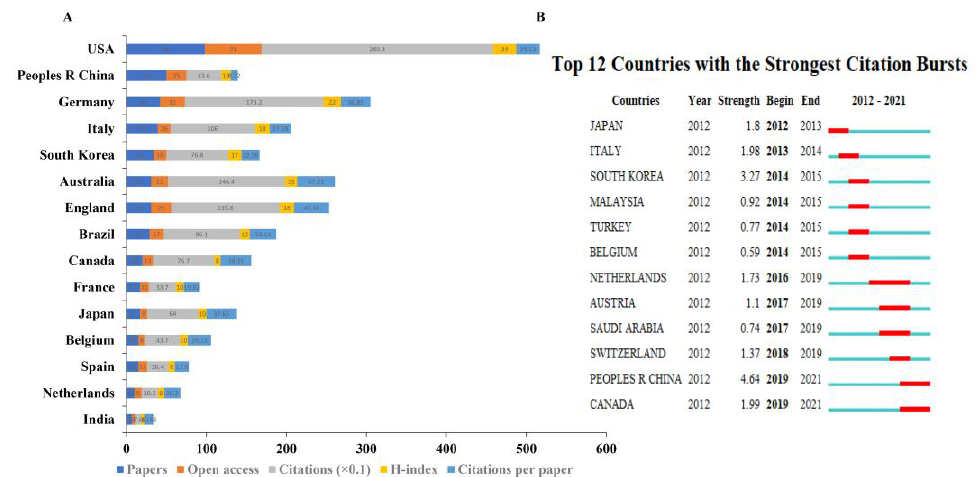
Figure 6. Distribution of global publications. ( A ) The amounts of papers, open access papers, citations, H-index, and citations per paper in the top 15 countries. ( B ) Top 12 countries with the strongest citation bursts using CiteSpace. The blue bars mean the reference was published; the red bars mean citation burstness.